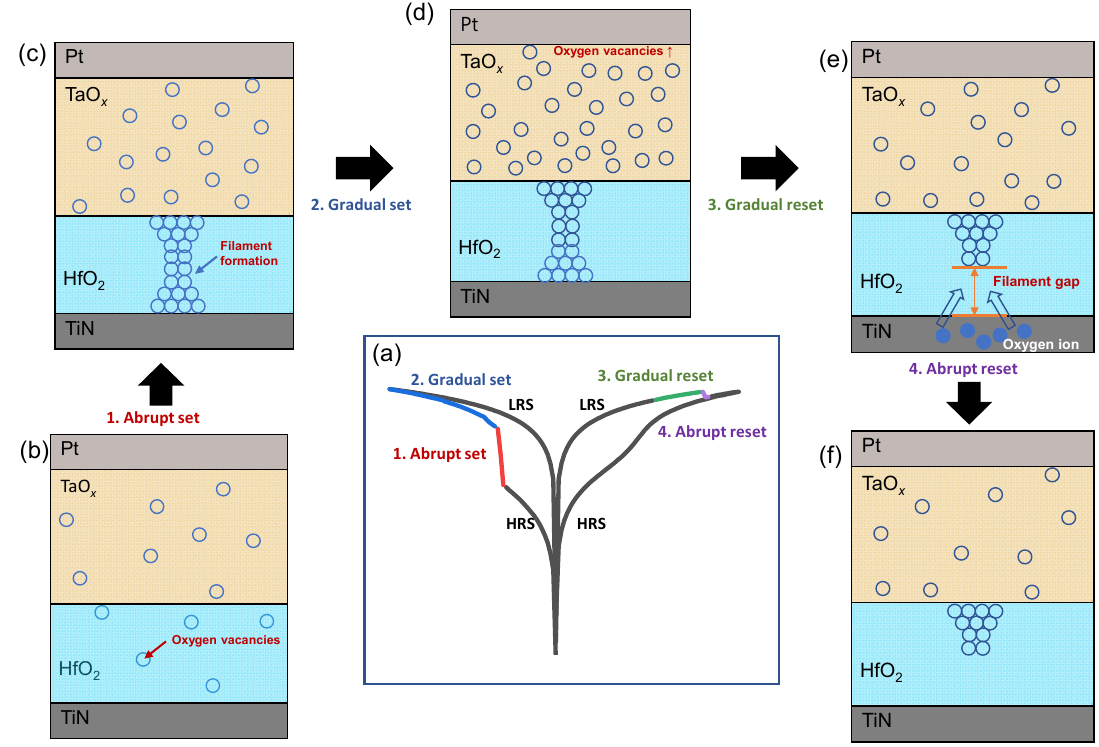
Figure 4. Switching model of the TaO x /HfO 2 memristor using conducting defects and filaments: ( a ) I ‐ V characteristics according to the voltage sweep; ( b ) high ‐ resistance state (HRS); ( c ) low ‐ resistance state (LRS) after abrupt set; ( d ) increased oxygen vacancies after an additional gradual set process; ( e ) reduced oxygen vacancies in the gradual reset process; ( f ) filament gap is open after an abrupt reset process.